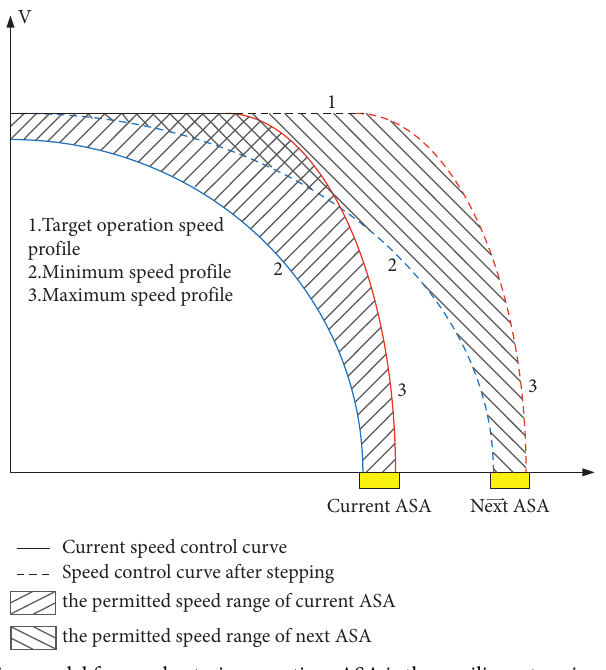
Figure 1: The stopping point stepping model for maglev train operation. ASA is the auxiliary stopping area. The speed control curve is the speed limit due to the line and train